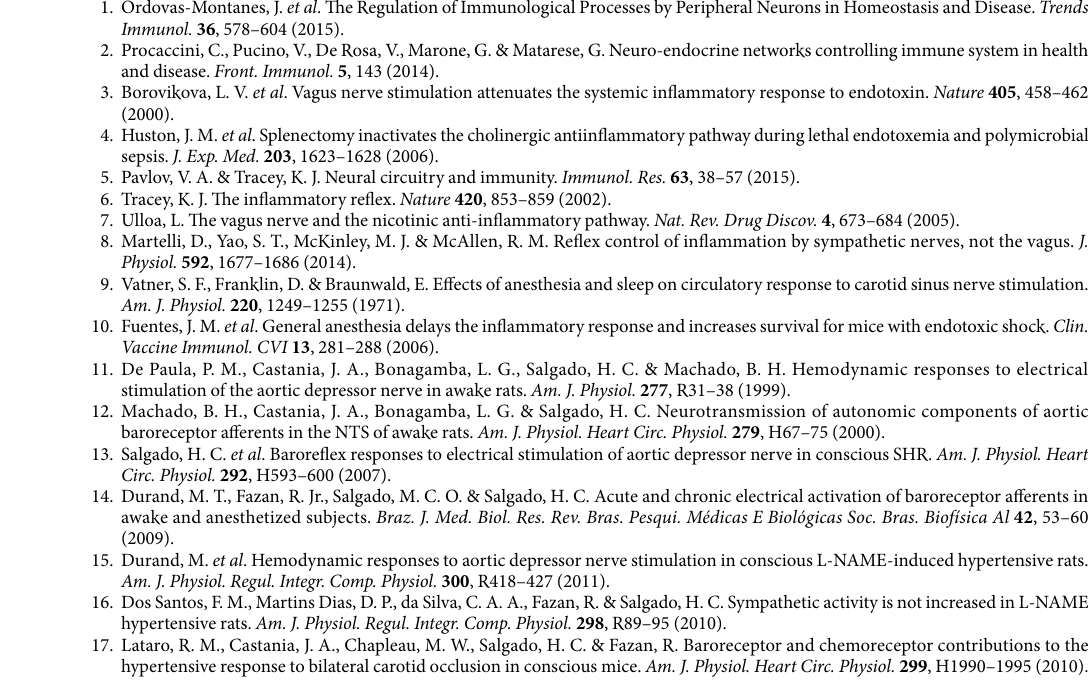
7 Scientific REPORTS | 7: 6265 | DOI:10.1038/s41598-017-06703-0